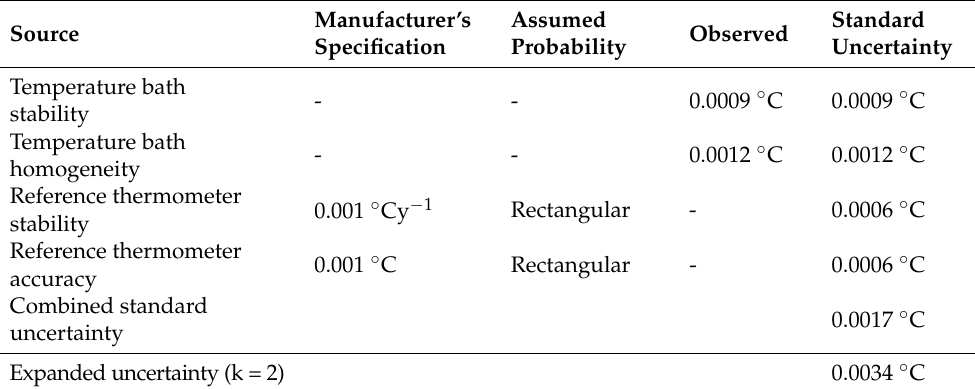
Table 4. The uncertainty of the temperature calibrations.